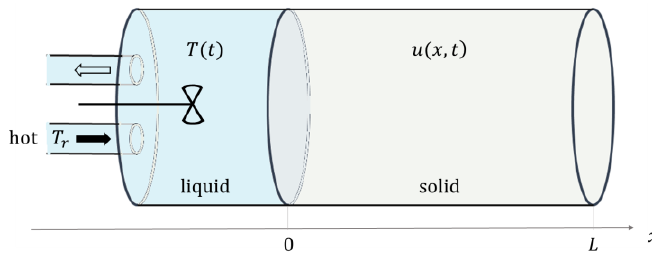
Figure 1. The physical system.